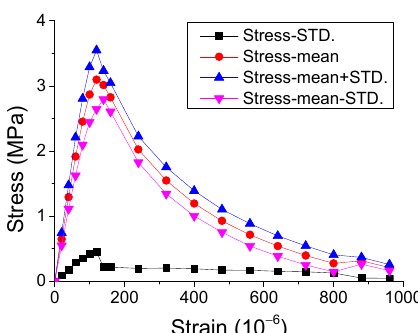
Figure 4. Mean and STD. of stress-strain response of SCC prismatic specimens under monotonic direct tension.